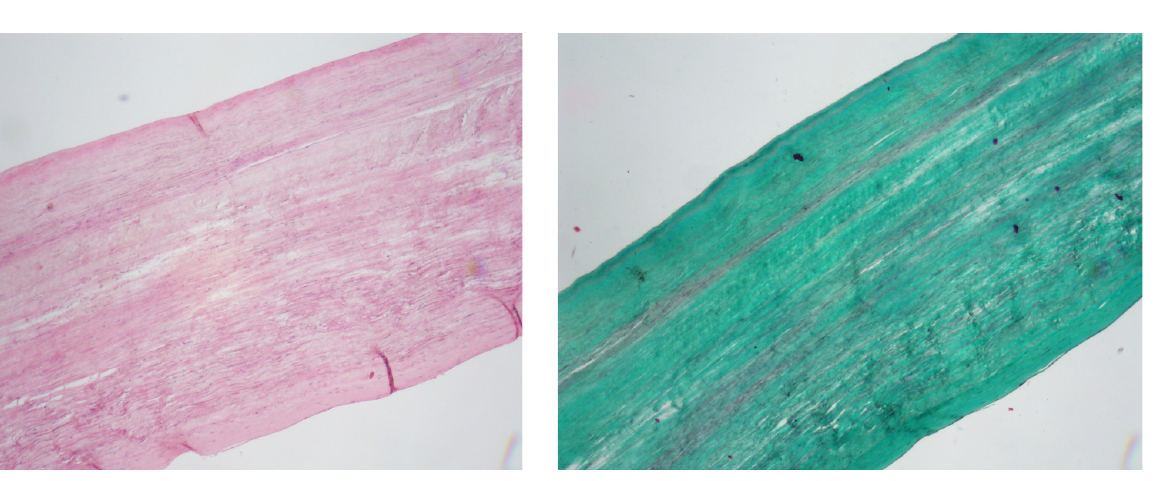
Fig. 5. Cardiac surgery. A fibrous chord-like material extirpated from the left atrium.